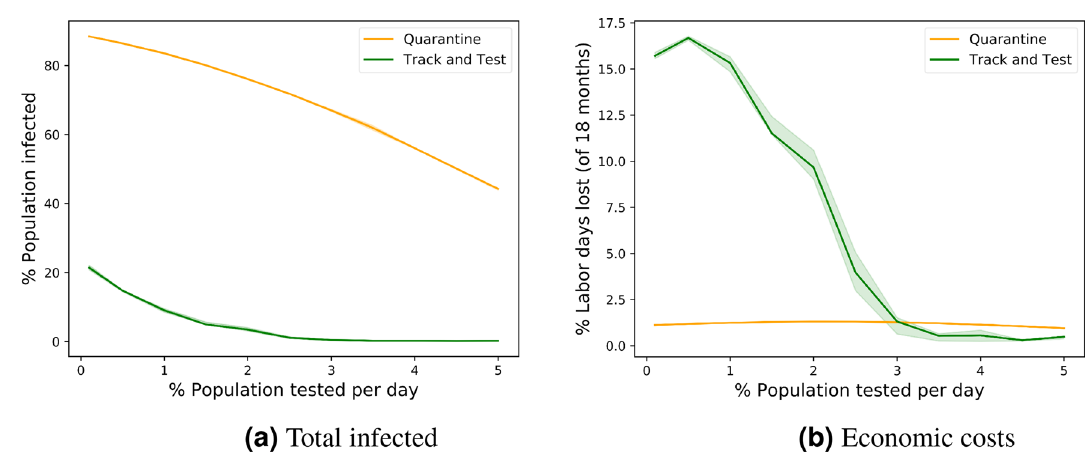
Figure 4. Effect of tests. A comparison between random tests and the Quarantine method and the bounded Track and Test method, as a function of the percentage of population tested each